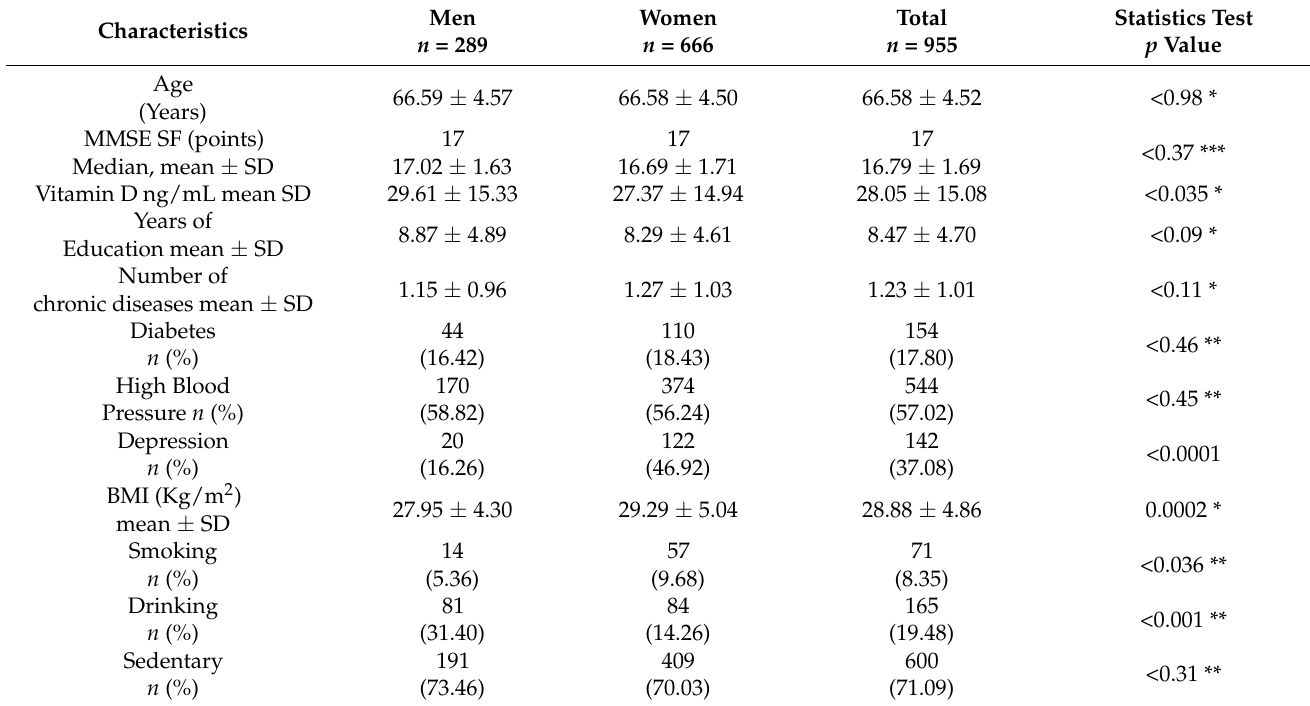
Table 1. General characteristics of the sample by